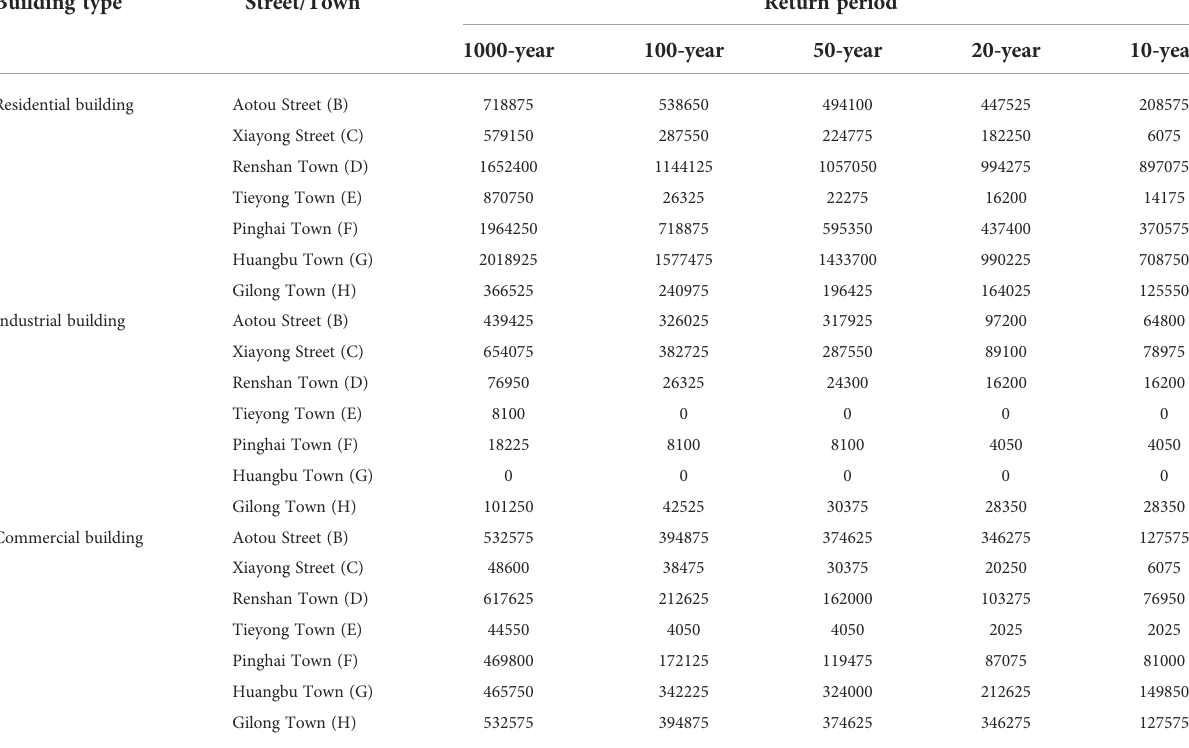
TABLE 6 Statistics of inundated area for different types of building in 8 streets/towns under different return periods of typhoon (m 2 ). Building type